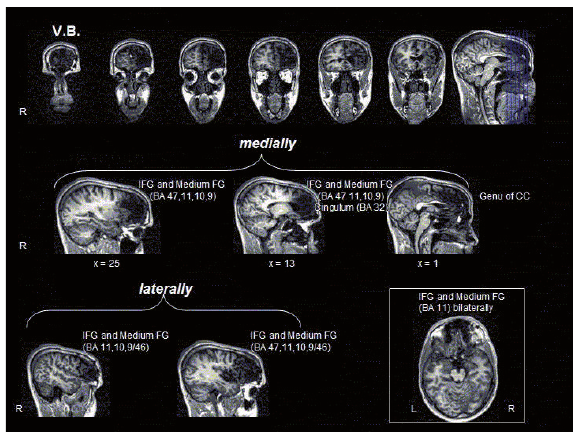
Figure 2: Localization of brain damage in V.B. See the text for